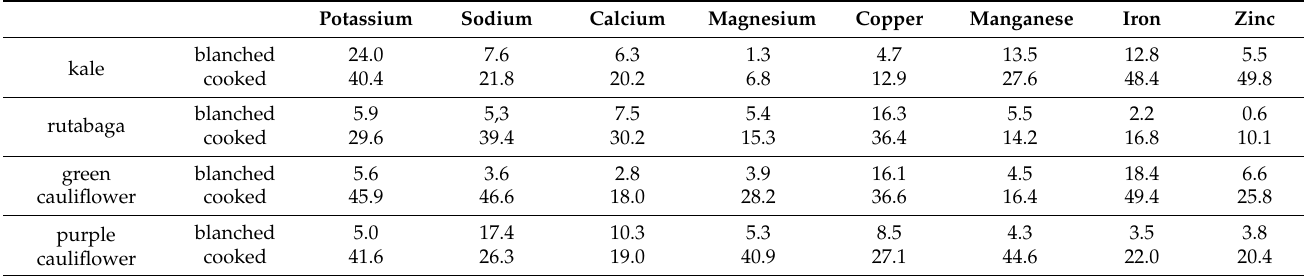
Table 2. Losses of selected minerals in in kale, rutabaga, green and purple cauliflower subjected to different technological processing (%)